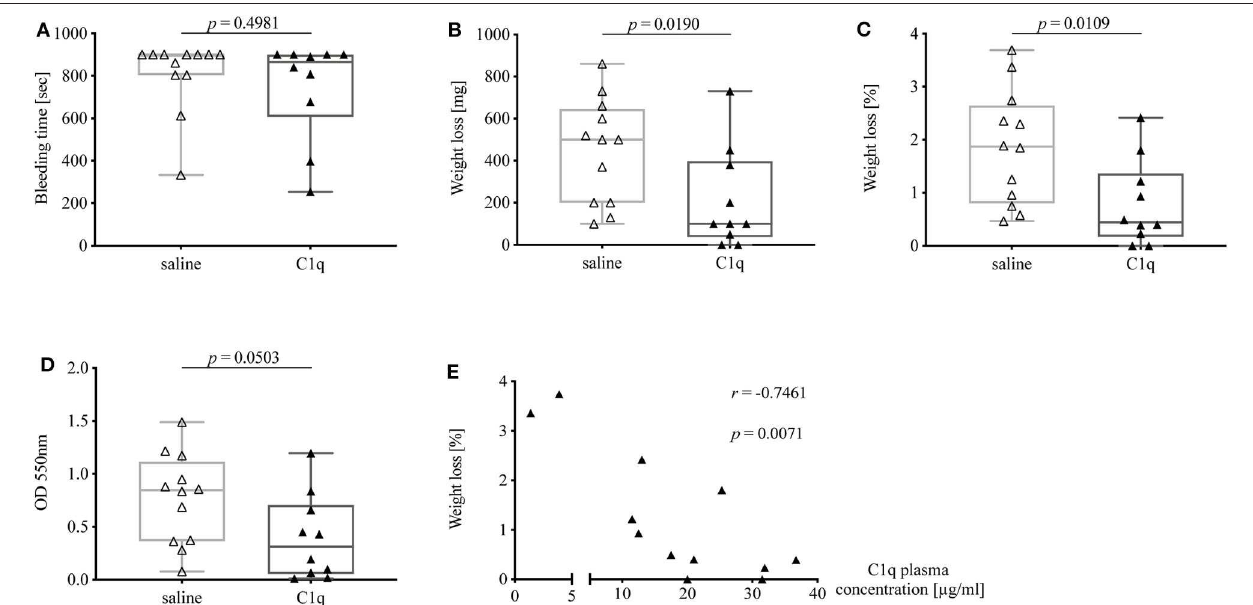
FIGURE 5 | Bleeding tendency of C1q-deficient mice with or without reconstitution with C1q. Tail bleeding assay was performed and bleeding tendency in C1q-deficient mice injected i.p. with either C1q or 0.9% saline 2h prior to assessment of (A) bleeding time, (B) weight loss, (C) relative weight loss normalized to the total body weight, and (D) OD of obtained blood-PBS solution. (E) Correlation between relative weight loss and achieved C1q plasma concentration in C1q-reconstituted C1q-deficient mice is shown. Horizontal lines in the box plots denote median while the boxes indicate interquartile range and whiskers minimum and maximum values. Data points represent individual mice, △ : n = 12, N : n = 10 (Mann–Whitney test; r , Spearman’s rank correlation